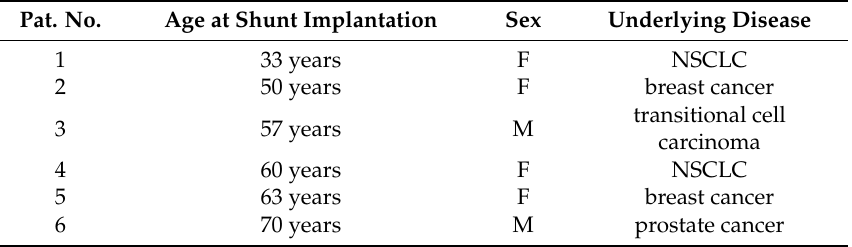
Table 3. Patient